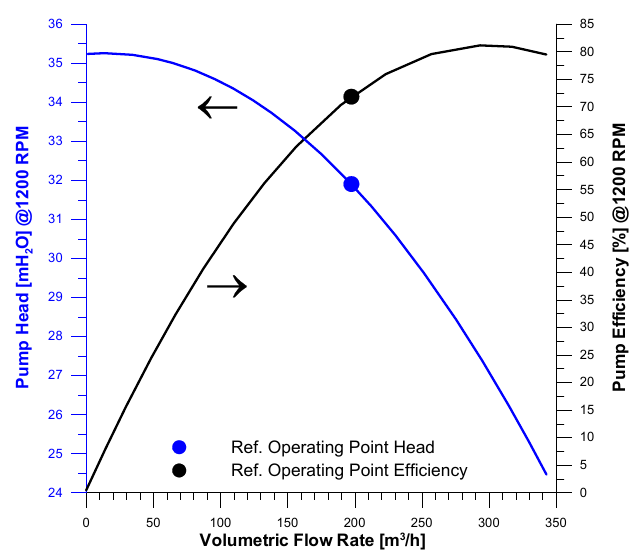
Figure 8. Head and Efficiency pump characteristic curves at reference pump speed (1200 RPM) and the reference operating point (Flow rate = 197.62 m 3 /h, Pump Efficiency = 71.8%, Pump Head = 31.90 mH 2 O).